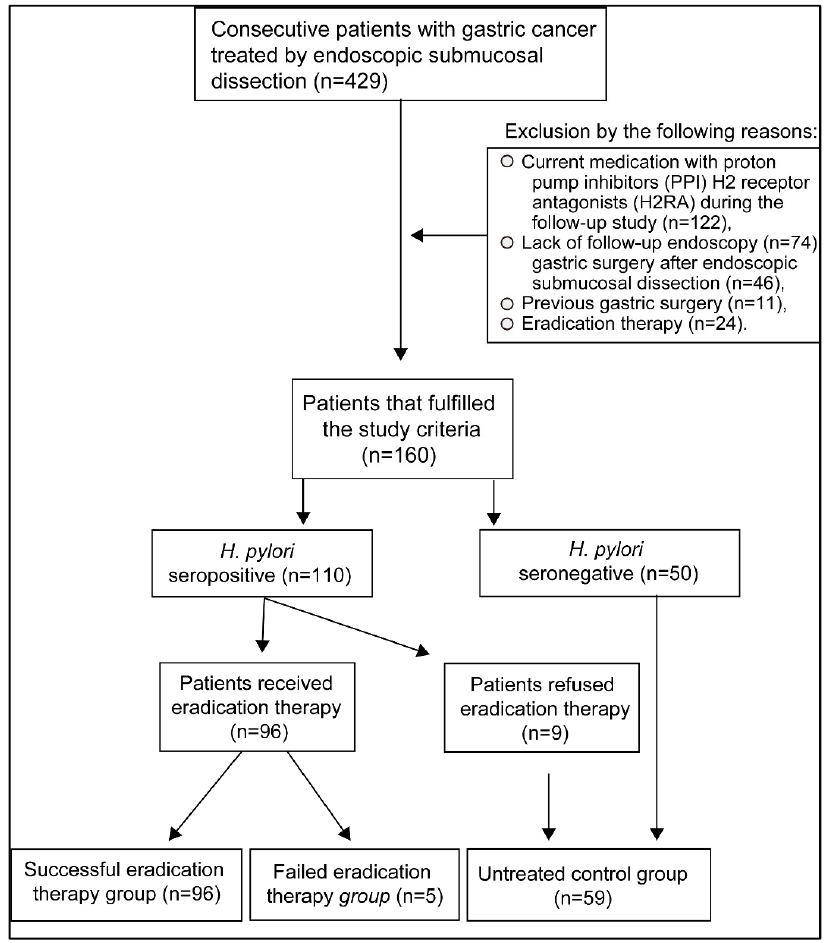
Figure 1. Study selection criteria. The records of 429 patients with early gastric cancer were evalu- ated. Patients that fulfilled the entry criteria were selected. evaluated. Patients that fulfilled the entry criteria were